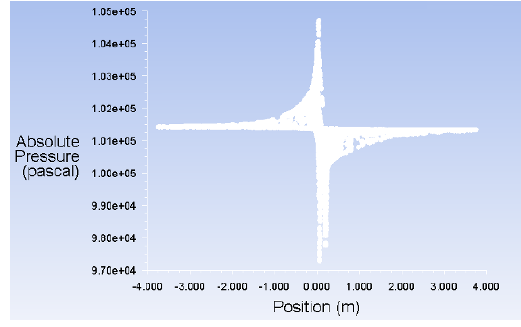
Figure 4. Centerline absolute pressure versus z-coordinate.